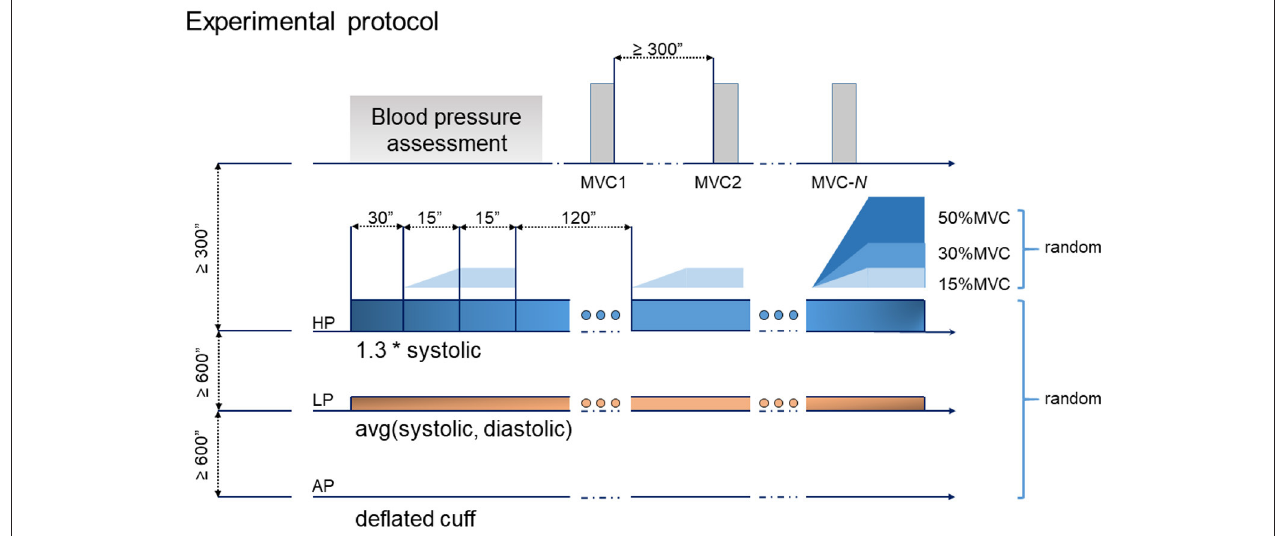
FIGURE 2 | Experimental protocol: the tasks consisted of 3 repetitions of a ramp and hold exercise. Each ramp lasted for 15 s, followed by a 15 s hold. Three levels of pressure and torque were randomized leading to a total of 9 experimental test